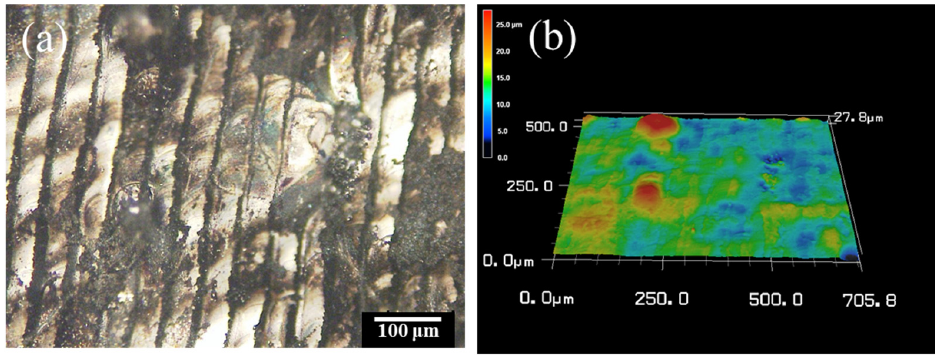
Figure 7. ( a ) OM image and ( b ) corresponding 3D surface morphology of single MoSiBTiC-La 2 O 3 layer with 50 μ m HD.